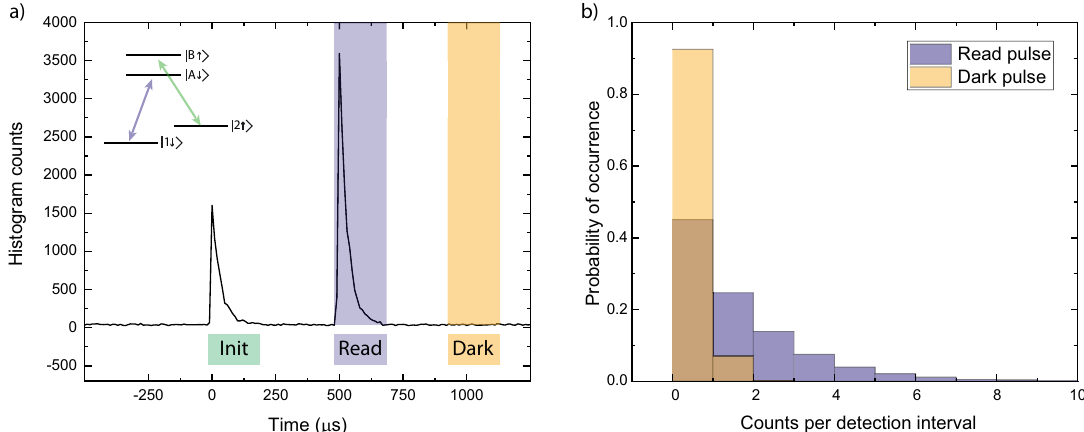
Fig. 5 Single shot readout measurement on a charge stabilised SnV − centre. a Histogram of the single shot readout measurement on Emitter 2. The 200 μ s long initialisation pulse resonant with the A1 transition initialises the spin with an ef fi ciency of 98.9(4) % in the state 2 "j i . For each 200 μ s long read pulse we detect an average of 1.21 (1.13) photons without (with) dark count substraction. b Histogram of photon counts in the readout time interval compared to a time interval of the same length where no laser pulse was applied. The overlap of the two measurements, while taking the imperfect state initialisation into account, yields a total readout fi delity of 74 % when setting 1 photon count as threshold for a state to be detected as